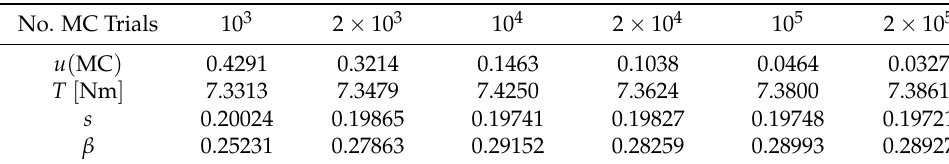
Table 4. Results from our Monte Carlo